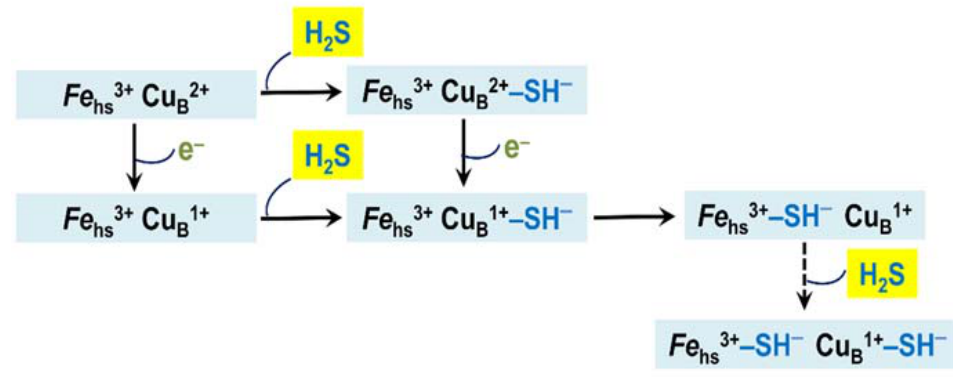
Figure 5. Proposed mechanism of inhibition of mitochondrial cytochrome c oxidase and Escherichia coli cytochrome bo 3 by H 2 S. Shown is the catalytic binuclear center in different redox and ligation states. The center consists of the copper ion Cu B and the high-spin heme ( Fe hs ). The latter is heme a 3 in cytochrome c oxidase and heme o 3 in cytochrome bo 3 . The metal redox groups which are not part of the center are not shown.